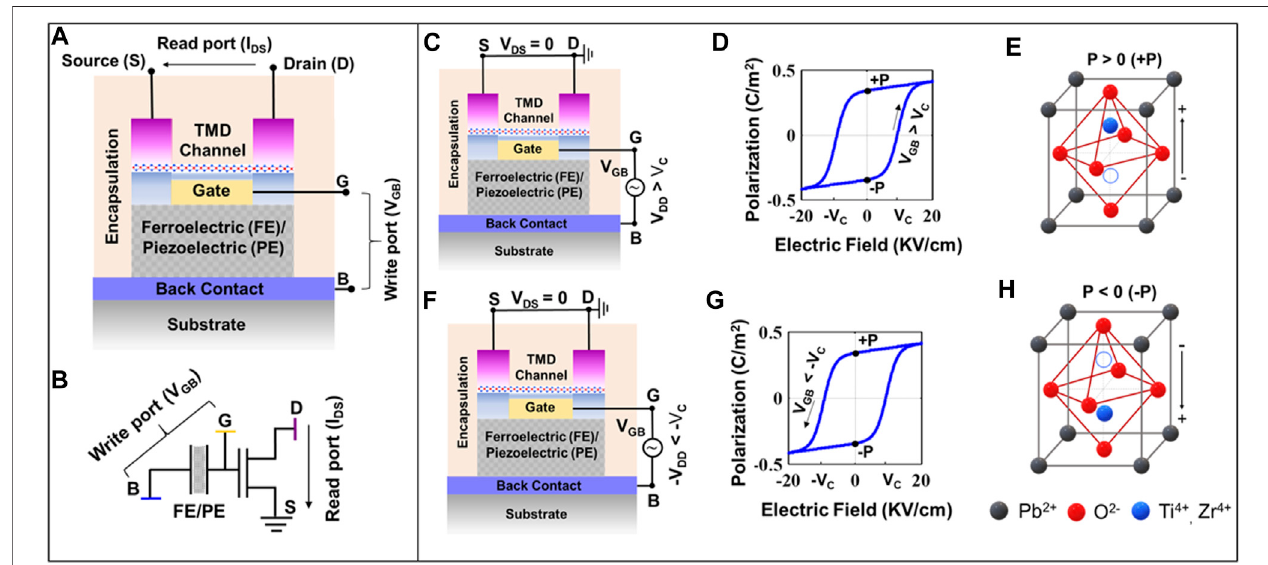
FIGURE 1 | (A) Device structure of PeFET showing its four terminals, namely, back (B) , drain (D) , gate (G) , and source ( S ). Ferroelectric or piezoelectric (FE/PE) material that extends non-volatile feature toPeFET isplaced between G and B terminals. (B) Schematic representation ofPeFET. Ferroelectric-based storagein PeFET. (C) Bias conditions of PeFET for +P polarization switching. (D) Polarization vs. electric fi eld response showing + P switching behavior for V GB > V C in PZT-5H, extracted fromtheexperimentalresultbyMalakootiandSodano(2013). (E) StructureofPZTinthe+ P stablestate. (F) BiasconditionsofPeFETfor − P polarizationswitching. (G) Polarization vs. electric fi eld response showing − P switching behavior for V GB < − V C in PZT-5H, extracted from the experimental result by Malakooti and Sodano (2013). (H) Structure of PZT in the − P stable